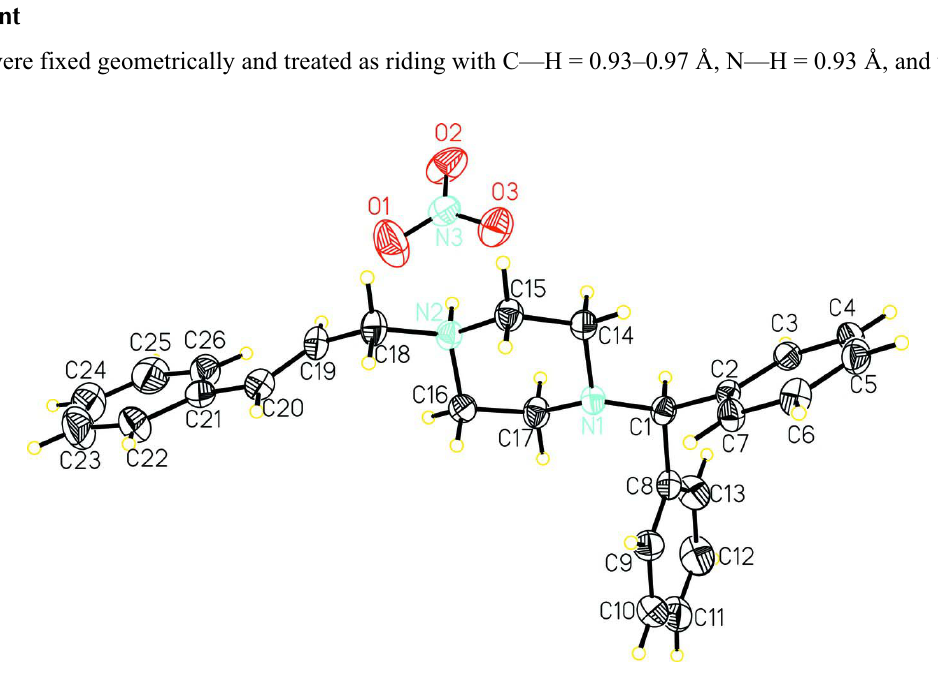
A view of the title compound with the atom numbering scheme. Displacement ellipsoids were drawn at the 30% probability